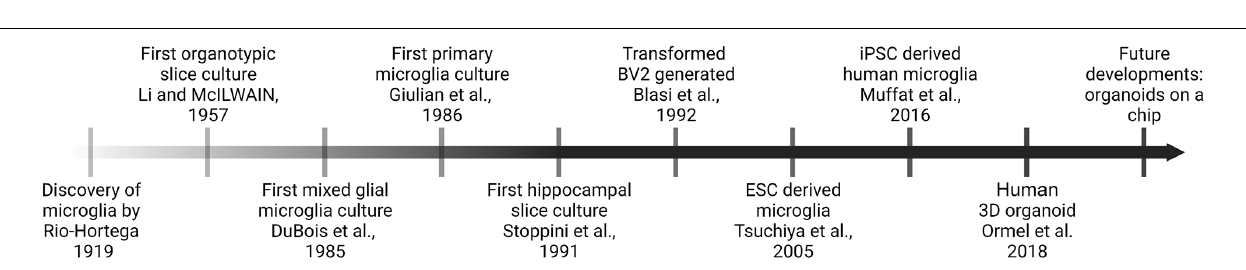
FIGURE 1 | Overview of available microglia in vitro approaches. Left panels: schematic representation of the cell culture model; middle panels: advantages and disadvantages of the in vitro approach; right panels: potential applications.